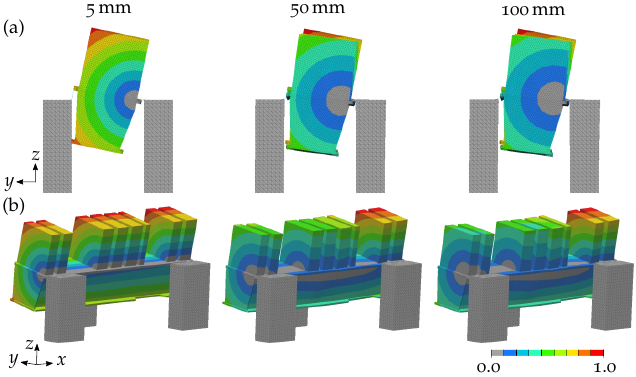
Figure 24. Side view ( a ) and 3D view ( b ) of the 1st mode shape of the magnet–girder assembly based on the PETRA III girder. The three different cross section diameters 5 mm, 50 mm, and 100 mm of the beams connecting the girder to the bases are considered. The colours represent the normalised vibration amplitude.